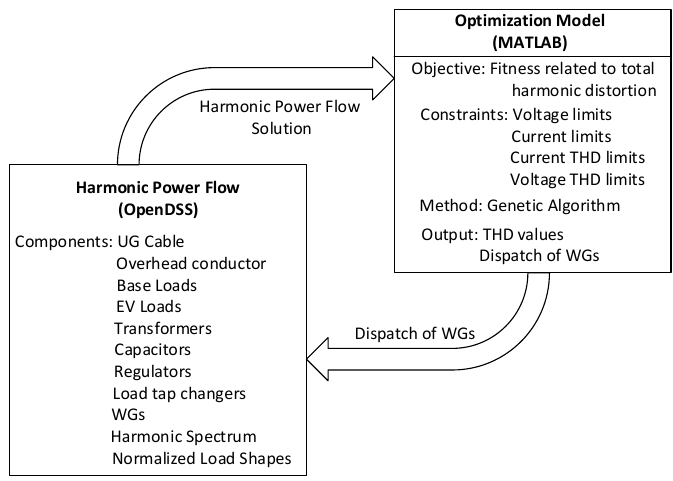
Figure 3. The developed interface between the harmonic power flow (HPF) model in OpenDSS and Optimization model in